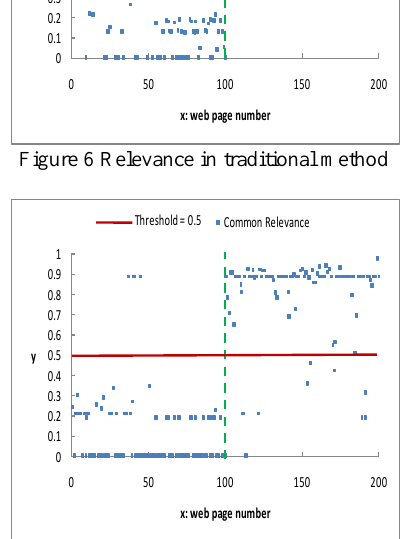
Figure 7 Common Relevance in proposed method